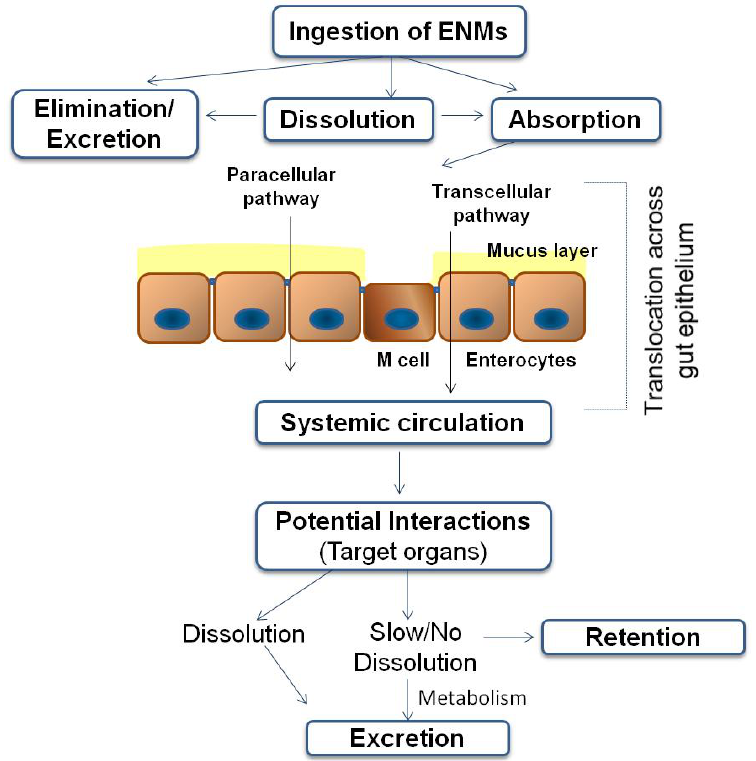
Figure 1. The fate of food-related ENMs in the GIT (modified from Cockburn et al .